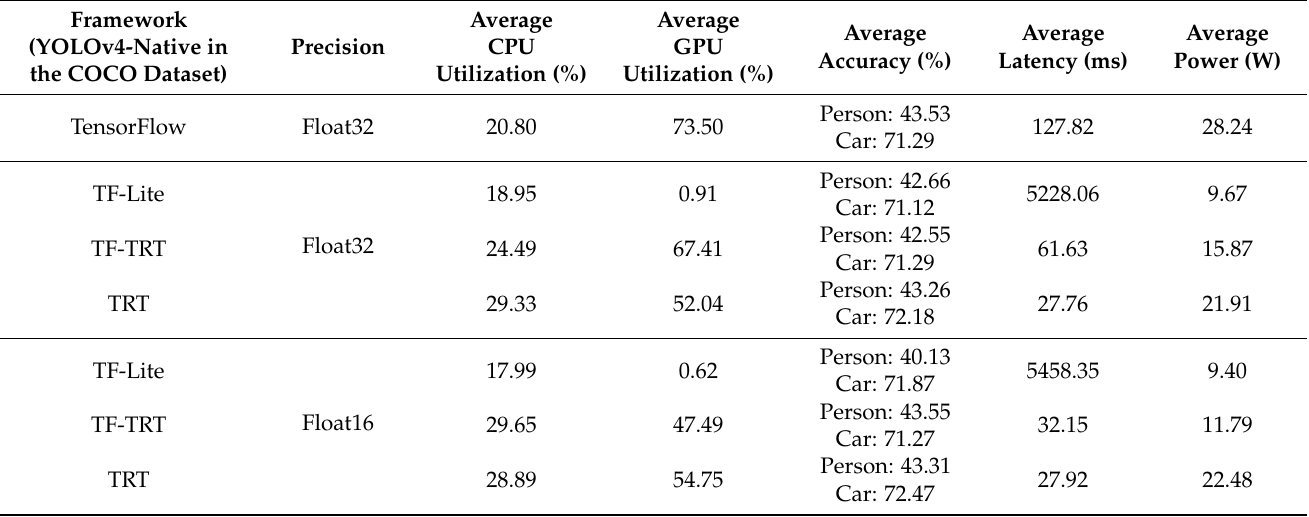
Table 2. Comparative analysis of YOLOv4-Native.weights’s inference performance in the COCO Dataset.